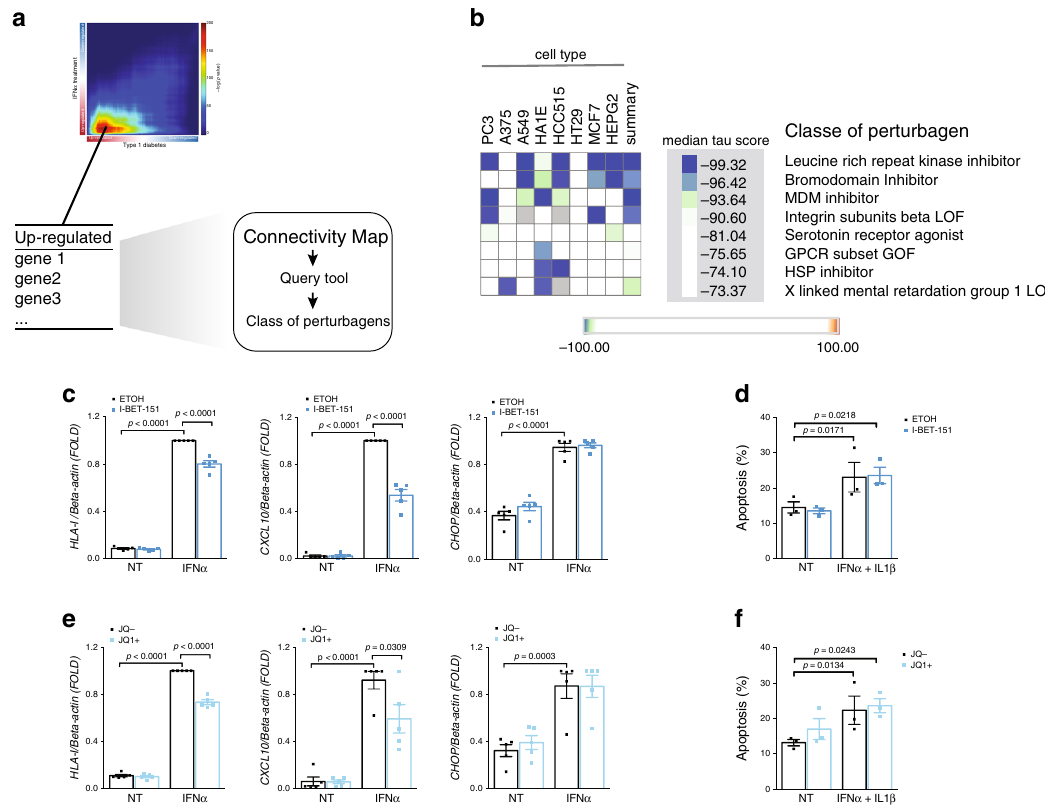
Fig. 7 Mining the type I interferon signature of pancreatic beta cells for identi fi cation of potentially T1D therapeutic targets. a The top 150 upregulated genes identi fi ed in Supplementary Fig. 2d were used to query the Connectivity MAP database of cellular signatures 49 . b Connectivity map classes of perturbagens that promote an opposite signature to the one shared between beta cells of T1D individuals and EndoC- β H1 cells exposed to IFN α (Supplementary Fig. 2d). c , e EndoC- β H1 cells were pretreated for 2 h with the bromodomain inhibitors I-BET-151 (1 μ M) ( c ) or JQ1 + (0.4 μ M) ( e ) and then exposed to IFN α for 24 h. Cells were collected and the mRNA expression for HLA class I (ABC), the chemokine CXCL10 and the ER stress marker CHOP (DDIT3) evaluated. Ethanol (vehicle) and an inactive enantiomer (JQ1 − ) were used as respective controls for I-BET-151 and JQ1 + . ( n = 5, mean ± SEM, ANOVA with Bonferroni correction for multiple comparisons). d , f Cell viability after exposure to the combination of cytokines IFN α (2000 U/ml) + IL1 β (50 U/ml) in the presence or not of the bromodomain inhibitors ( n = 3, mean ± SEM, ANOVA with Bonferroni correction for multiple